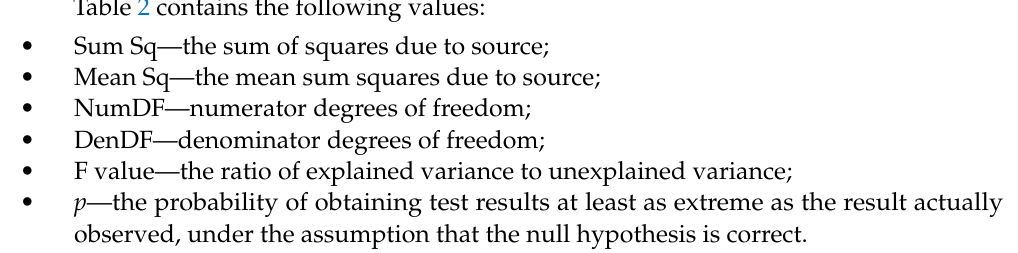
Table 2 contains the following